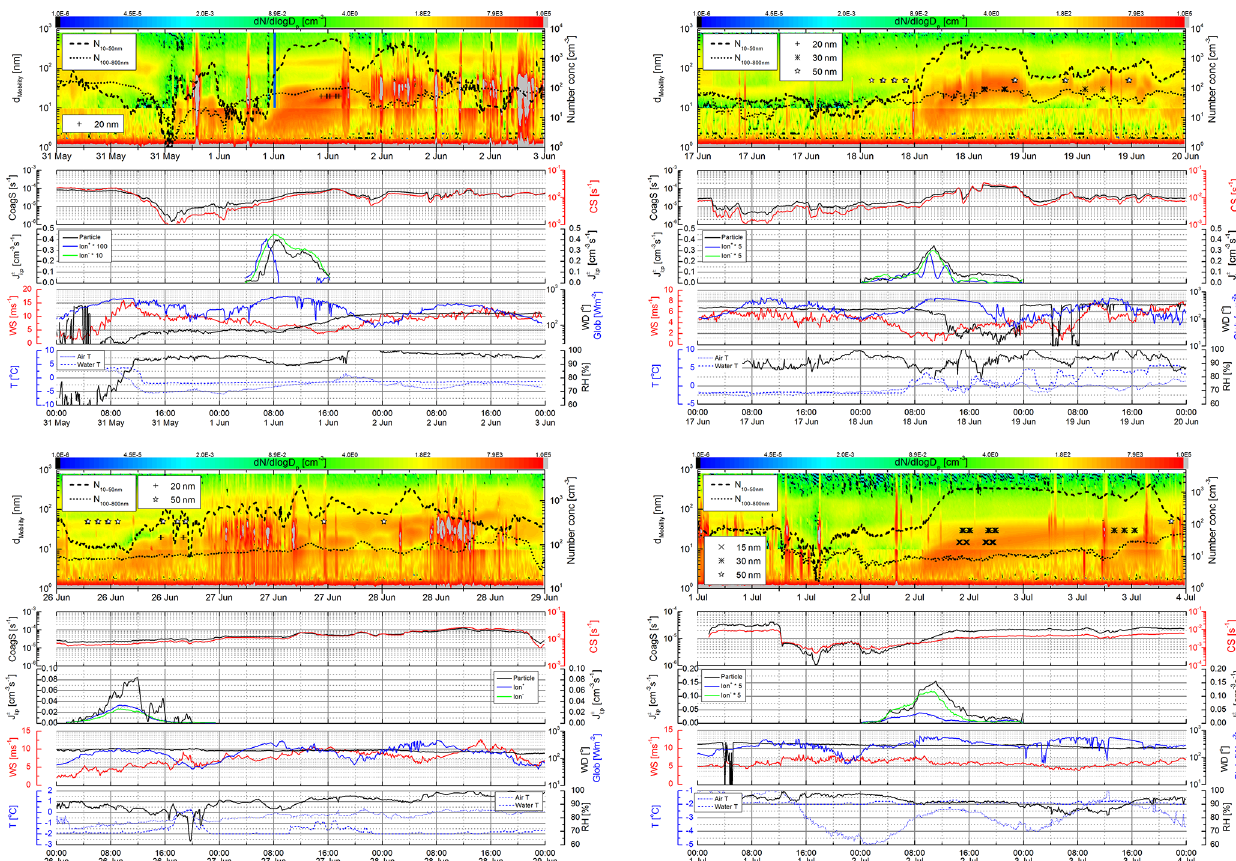
Figure 2. The NPF events observed during RV Polarstern cruise PS106. The PNSDs from NAIS (negative polarity) and MPSS are shown as contour plots. The color scale represents particle number concentration as d N/ dlog D p . Inside the contour plots, particle number concentra- tion, integrated between two size ranges (10 to 50 and 100 to 800nm), is shown with dashed and dotted black lines. The presence of corona charger ions ( < 2nm, Manninen et al., 2011) can also be seen in NAIS data. This artifact was excluded from data analysis. Coagulation and condensation sinks, meteorological parameters (wind speed and direction, global radiation, temperature, and relative humidity), and forma- tion rates ( J ) for each NPF event are shown in the panels below the contour plots. Note: sample contamination by ship exhaust was removed from data analysis; however, for better representation of particle growth, the contour plots include all the data (contamination not